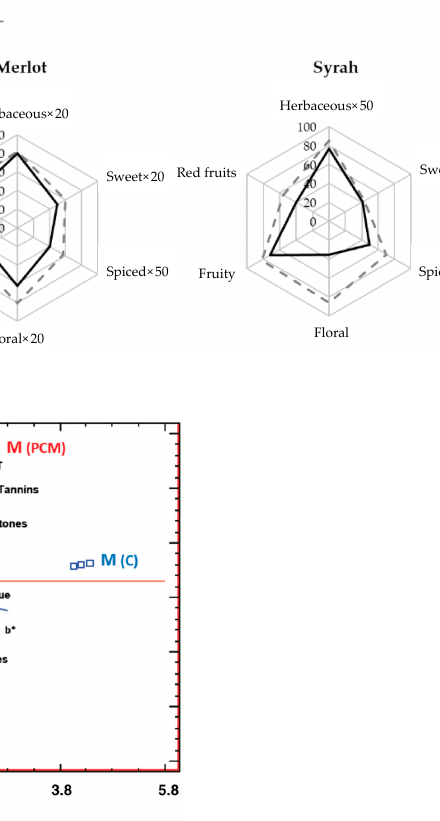
Figure 3. Scores of the samples and variables in the plane are defined by the two principal components. Young wines of M: merlot; S: Syrah; T: Tempranillo.